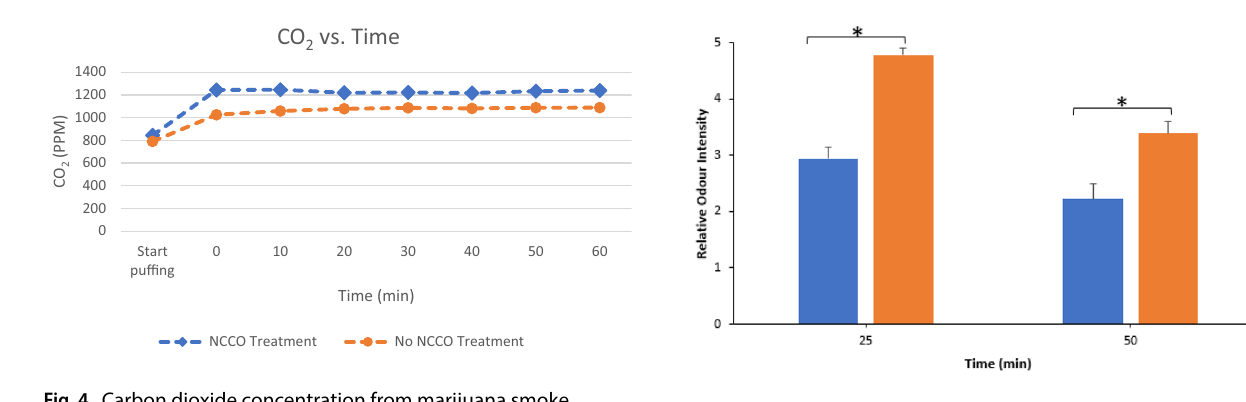
Fig. 4 Carbon dioxide concentration from marijuana smoke